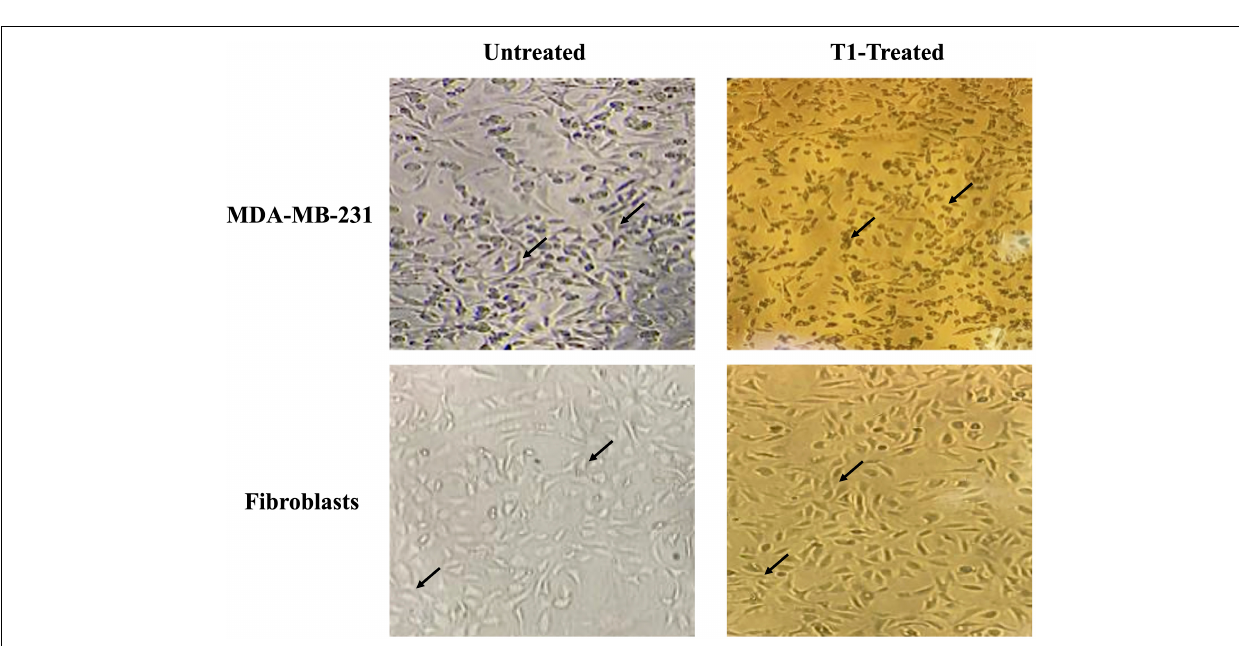
FIGURE 2 | (A) Effect of different concentrations of T1 extract on cell viability of MDA-MB-231 cells after 48 h of treatment. Data indicate an inverse relationship between concentrations of T1-extract and cell proliferation in MDA-MB-231 cells as compared to the vehicle control (methanol). (B) Effect of T1 on cell viability of fibroblasts after 48 h of treatment. Data are presented as a percentage of treatment relative to the control (Mean ± SEM; n = 3). *** p < 0.0001. VC, Vehicle control.